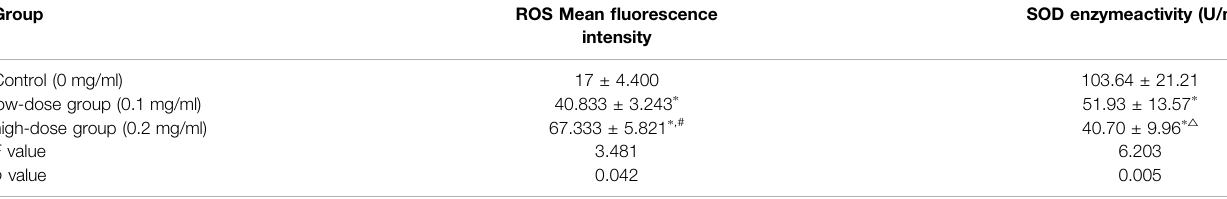
TABLE 1 | Effects of different dose of PM2.5 on BMCs ROS and total SOD activity ( ‾ x ± s ).